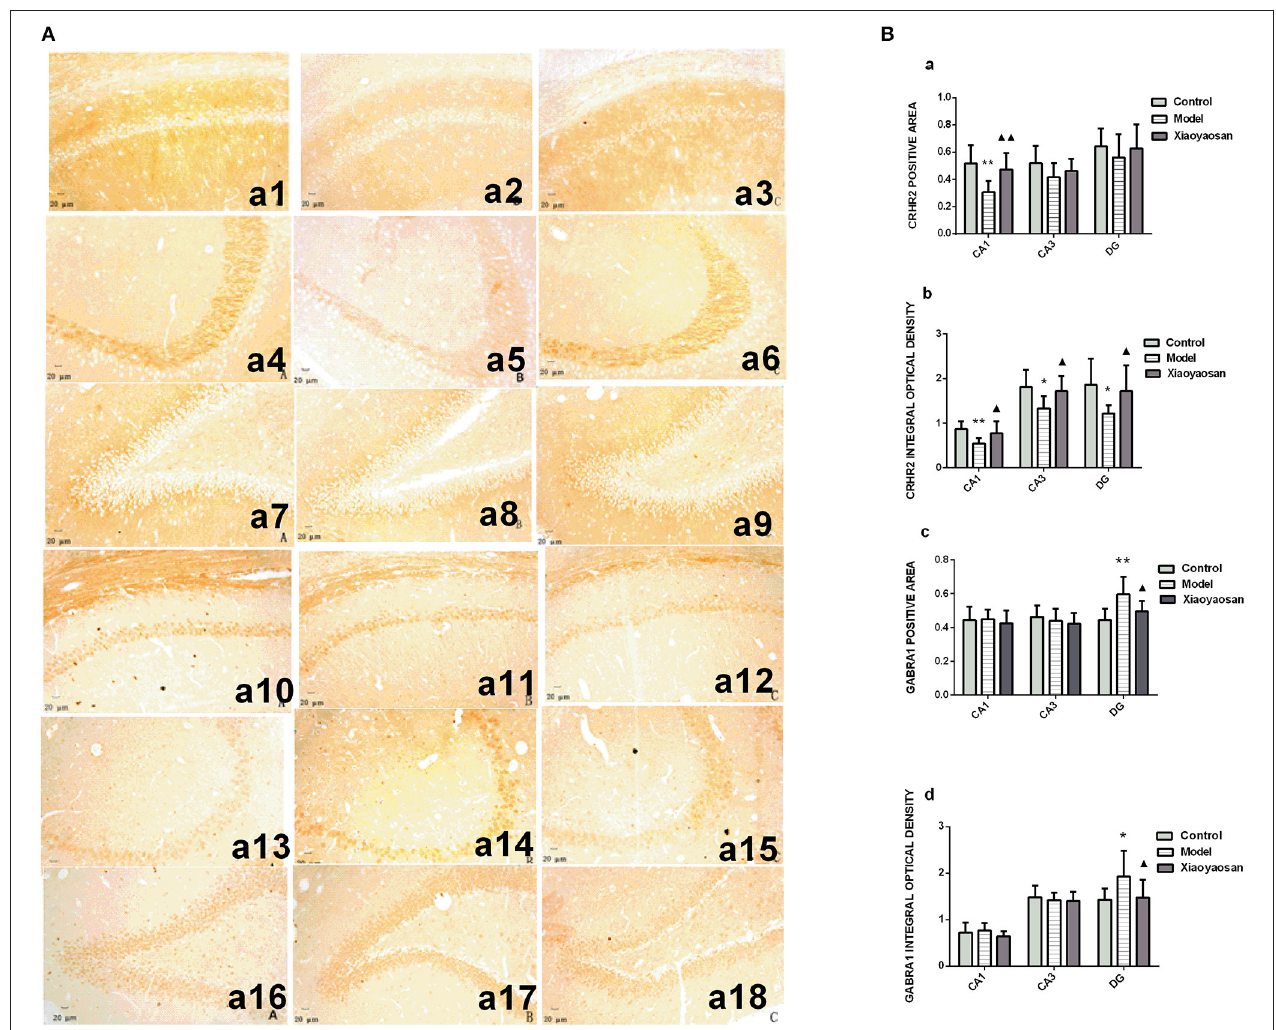
FIGURE 5 | Effects of Xiaoyaosan on the levels of the CRHR2 and GABRA1 proteins in the rat hippocampus. (A) Levels of the CRHR2 and GABRA1 proteins in the hippocampal CA 1 , CA 3, and DG regions. Levels of the CRHR2 protein in hippocampal CA 1 (a1–a3) , CA 3 (a4–a6) , DG (a7–a9) regions of the control, model, and Xiaoyaosan groups. Levels of the GABRA1 protein in the hippocampal CA 1 (a10–a12) , CA 3 (a13–a15) , DG (a16–a18) regions of the control, model, and Xiaoyaosan groups. (B) Changes in the levels of the CRHR2 and GABRA1 proteins in the rat hippocampus. (a) CRHR2-positive area. (b) Integrated optical density of the CRHR2 protein. (c) GABRA1-positive area. (d) Integrated optical density of the GABRA1 protein. Values are presented as the means ± SD from 10 rats per group. * P < 0.05 and ** P < 0.01 compared with the control group. N P < 0.05 and NN P < 0.01 compared with the model